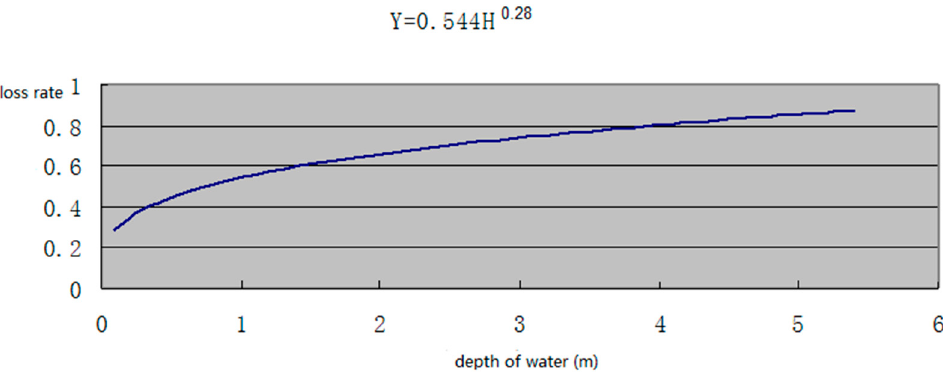
Figure 10. Flood loss rate curve of brick–wood buildings in the study area.